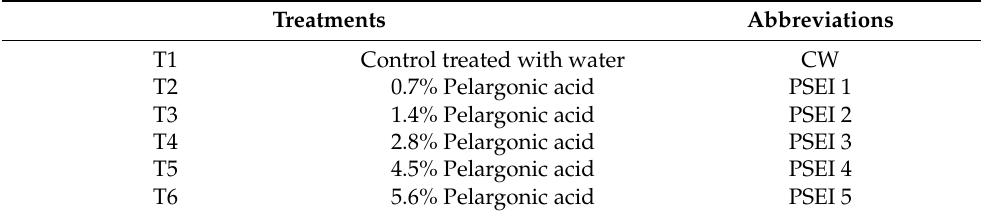
Table 2. Herbicidal treatments tested under greenhouse